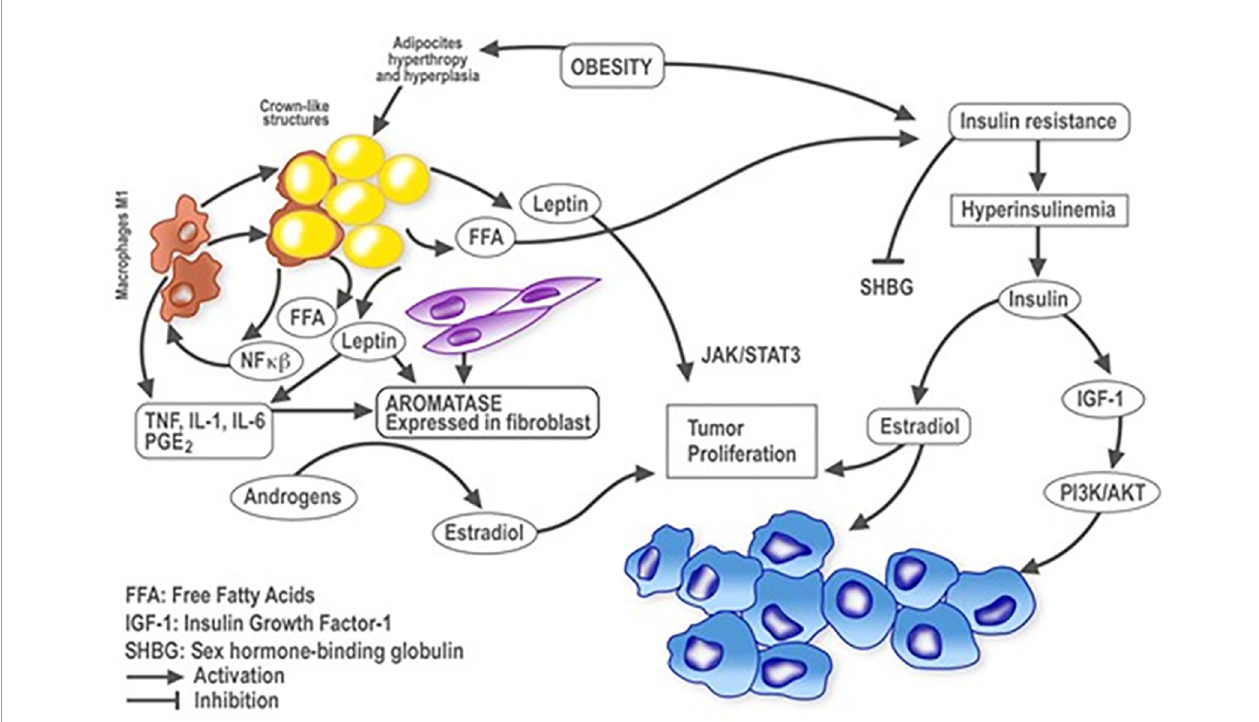
FIGURE 1 | Plausible relationships between obesity and in fl ammation in breast cancer. Schematic representation of cellular and molecular events in fl uenced by obesity and in fl ammation in the context of breast cancer development. Lines with arrowheads indicate activation; with fl at ends, inhibition. NF-kB, nuclear factor kappa-light-chain-enhancer of activated B cells; TNF a , tumor necrosis factor alpha; IL, interleukin; PGE2, prostaglandin E2; FFA, free fatty acids; IGF-1, insulin growth factor 1; SHBG, sex hormone binding